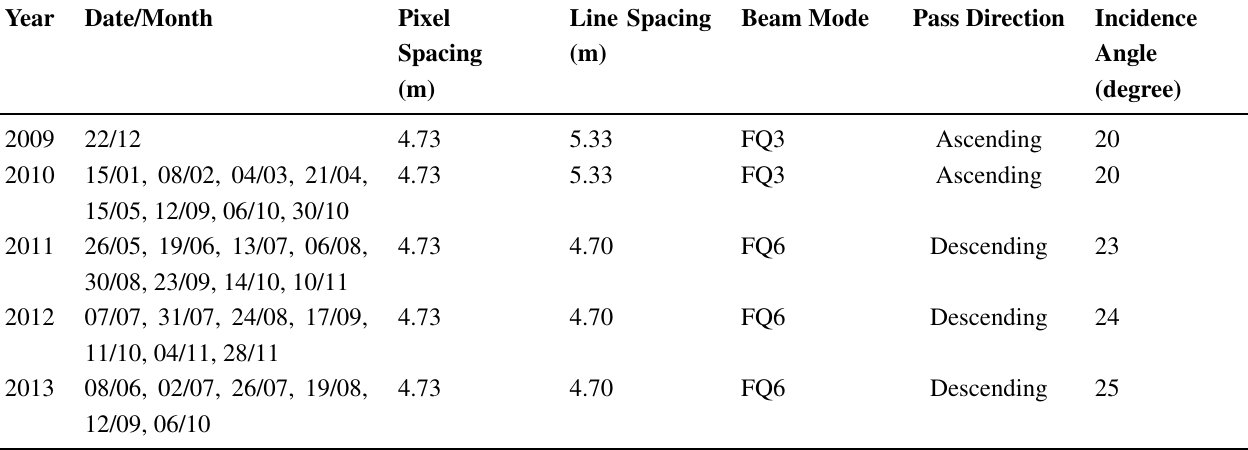
Table 1. Details of the RADARSAT-2 images used in the